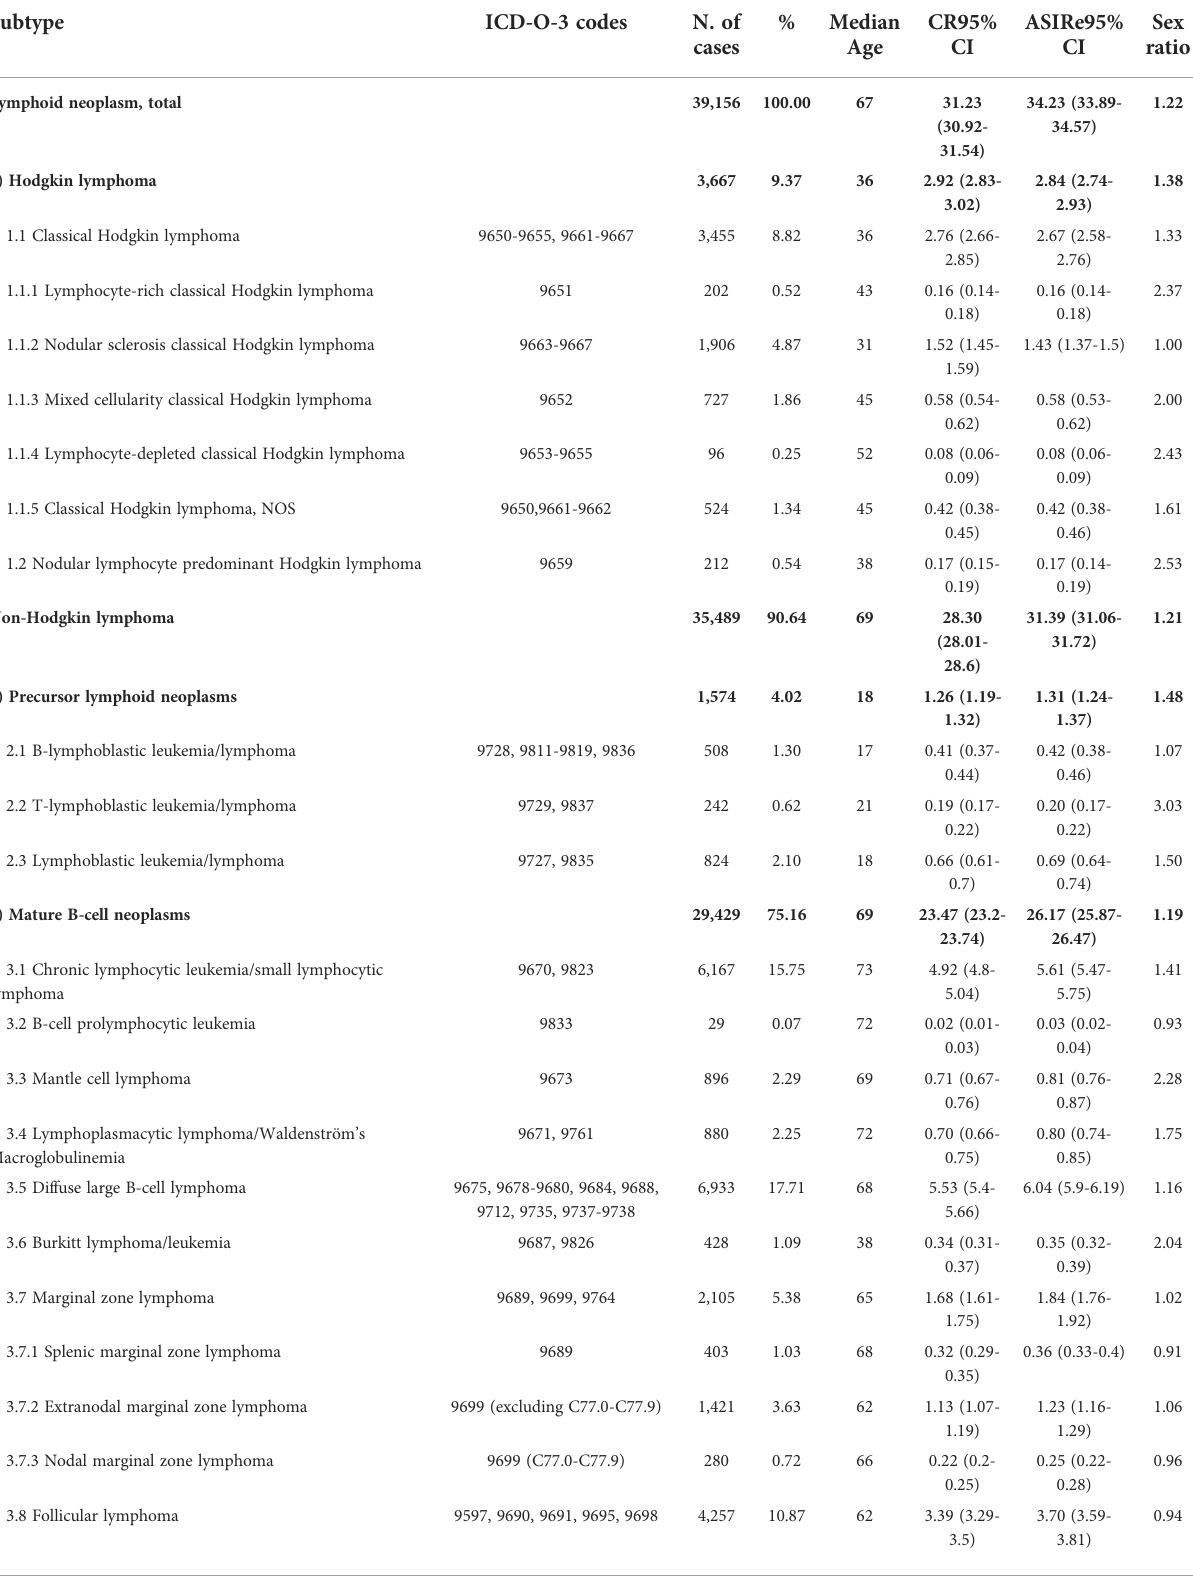
TABLE 1 Crude and age-adjusted incidence rates of lymphoid neoplasms diagnosed in Spain,